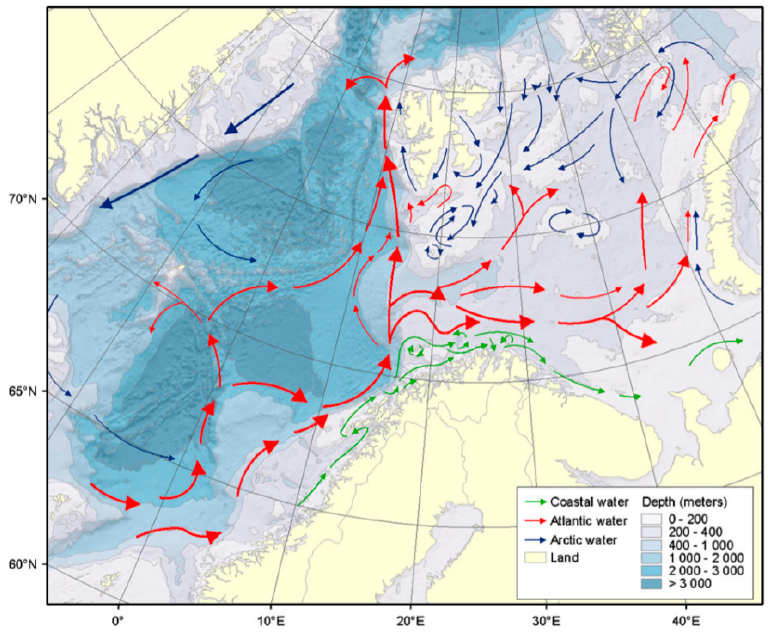
Figure 3. Main water currents of the Barents Sea [38] .